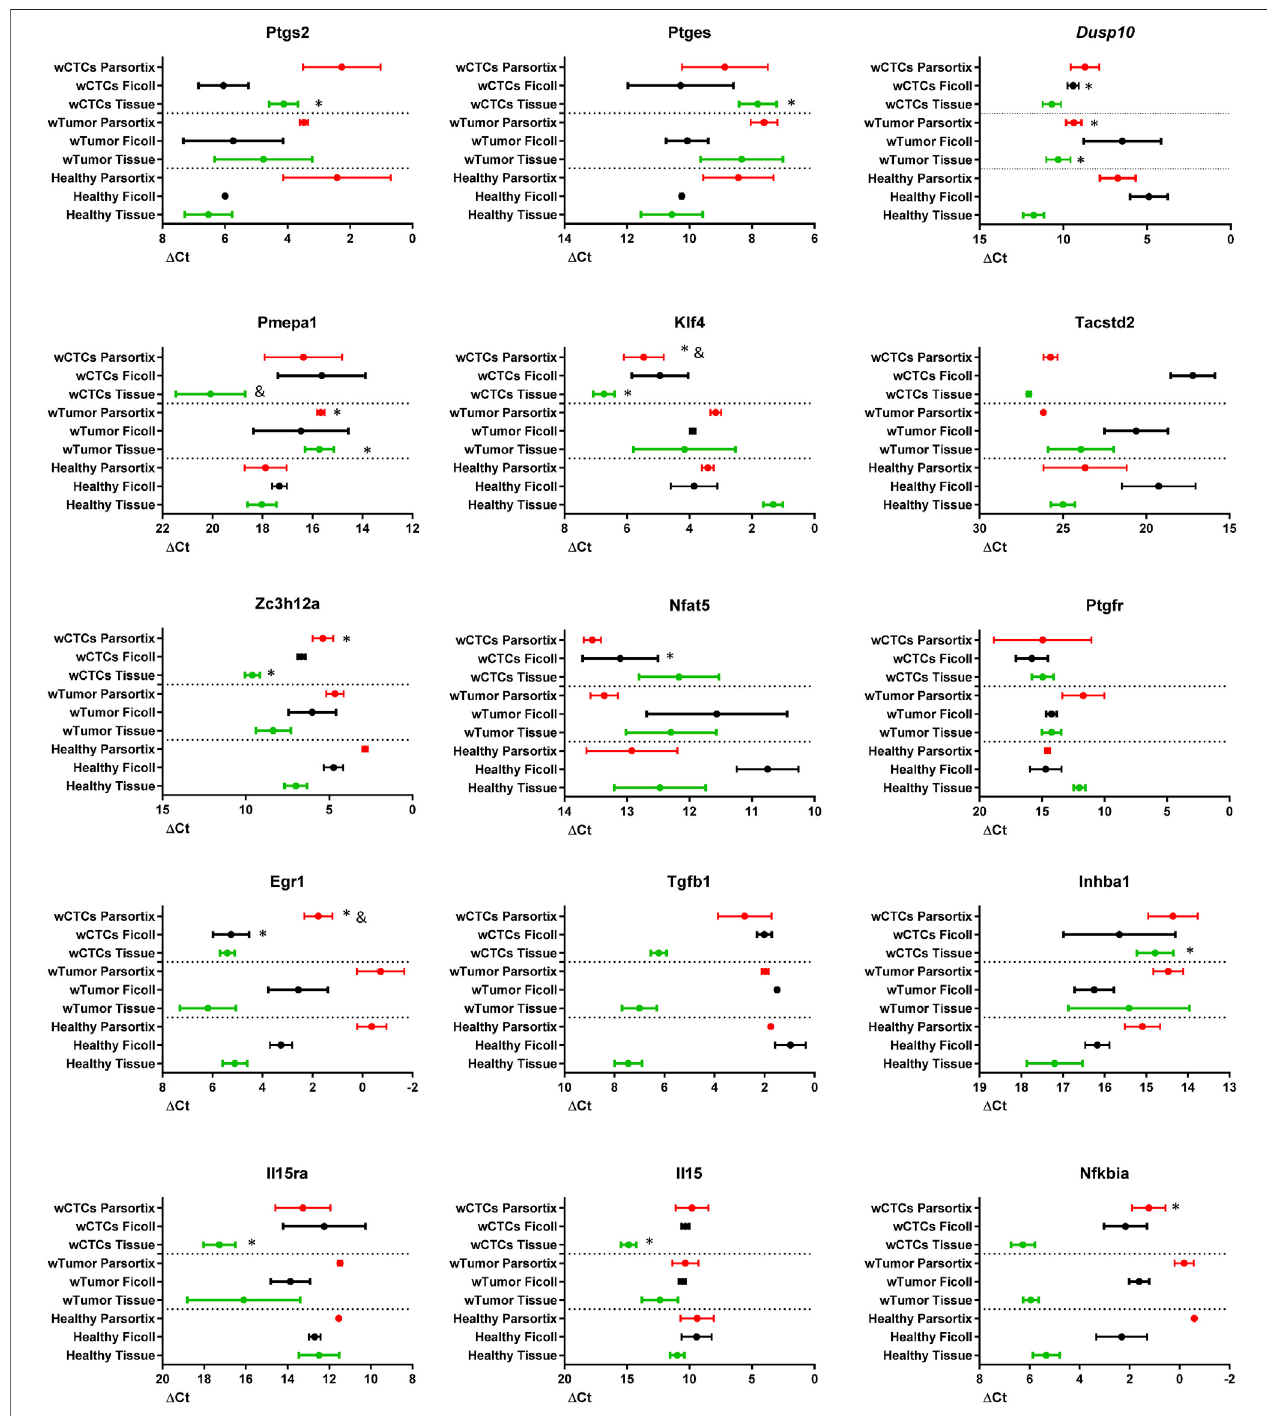
FIGURE 4 | mRNA levels of the indicated genes in solid tissue (green, normal colon or tumor), Ficoll isolate (black), and Parsortix isolate (red) in healthy ( Healthy ), tumor-bearing ( wTumor ), and tumor-bearing with detectable CTCs ( wCTCs ) mice, as estimated by RT-qPCR. Δ Ct values are shown, with SEM, plotted on an inversed axis,tofacilitateinterpretation: left=high Δ Ct=lowmRNAlevels;right=low Δ Ct=highmRNAlevels.Wilcoxontestwasperformedforstatisticalsigni fi cance.*:p < 0.05 when compared to healthy of the same extraction method. &: p < 0.05 when compared to wTumor of the same extraction method.